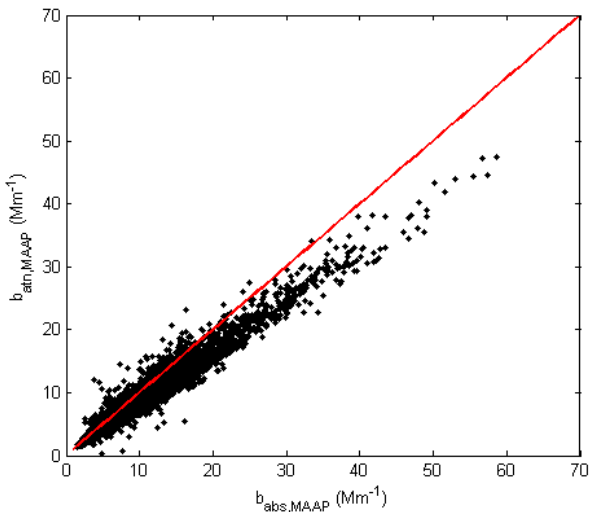
Figure 1. Non-compensated absorption coefficient ( b atn , MAAP ) vs. compensated absorption coefficient obtained from the reflected sig- nal ( b abs , MAAP ) , showing the relationship between the b atn , MAAP given by the MAAP, as explained in Sect. 2.2, and the compensated b abs , MAAP obtained with the reflected signal at 165 ◦ .